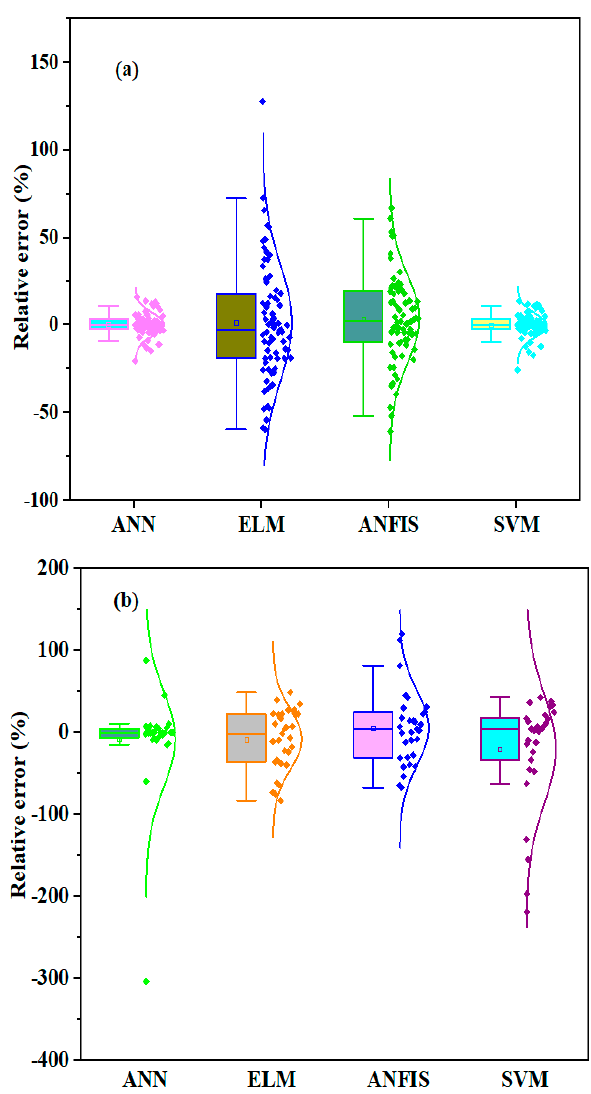
Figure 11. Relative error distribution for the developed model using Boxplot at ( a ) training and ( b ) testing phase.